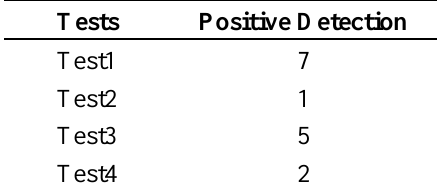
Table 2. The tests batch and the positive detection of each